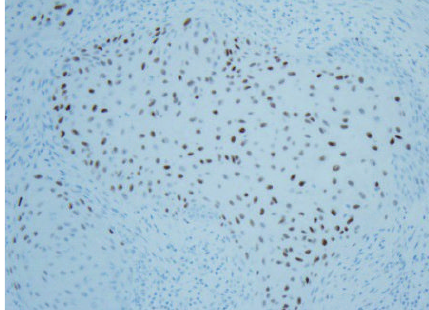
Figure 8: Positive nuclear immunostaining for p53 in invasive nests (p53, 20x).